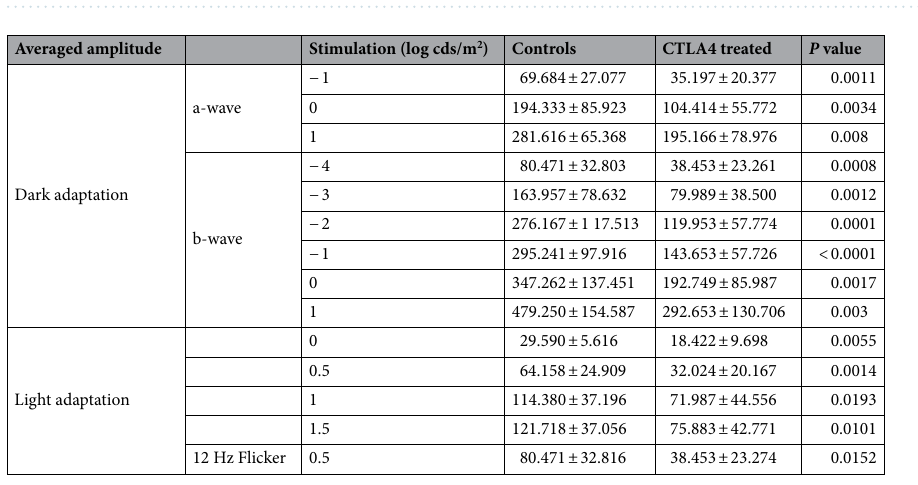
Table 1. Mean responses (μV) for the a-wave, b-wave, cones, and 12-Hz flicker tests for control and treated eyes (n = 5 in each group).